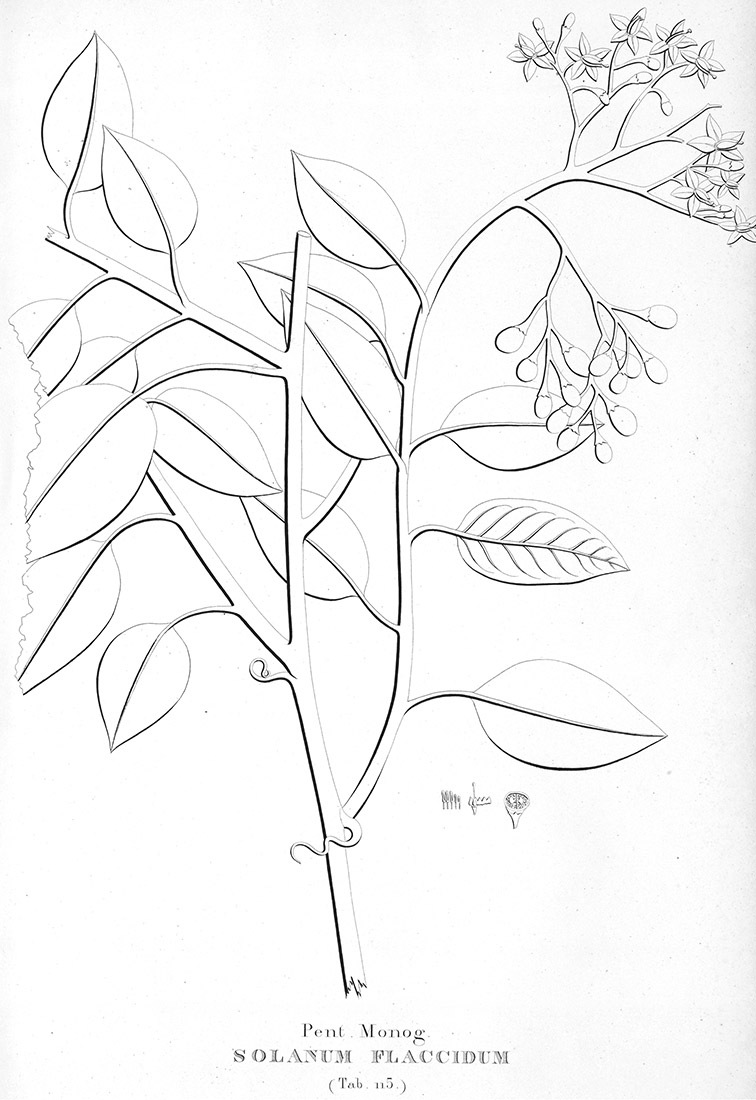
Lectotype of Solanum flaccidum Vell. (Vellozo 1831: tab. 115). Reproduced with permission of the Natural History Museum Botany Library.